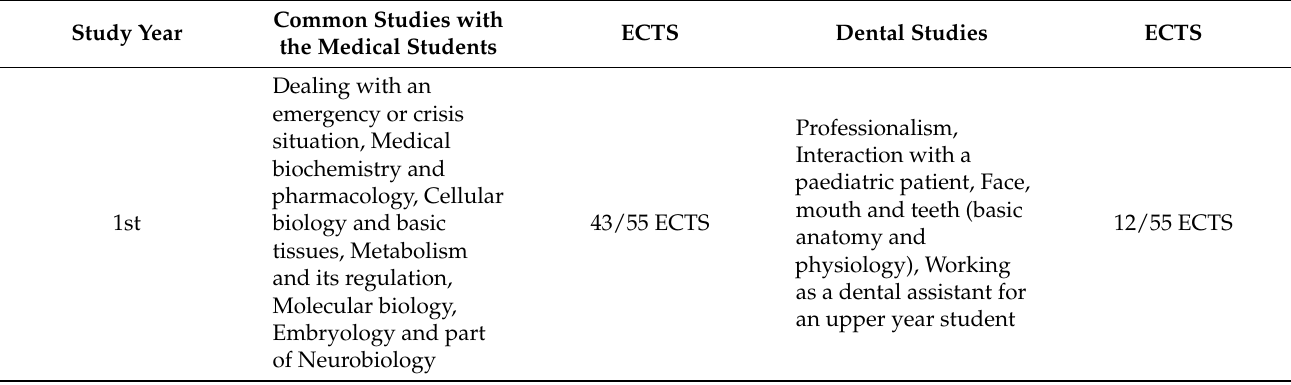
Table A1. Annex 1. Curriculum content and the number of ECTS (European Credit Transfer and Accumulation System) credits per study year at the University of Helsinki (for students who started their studies before the year 2015). Study